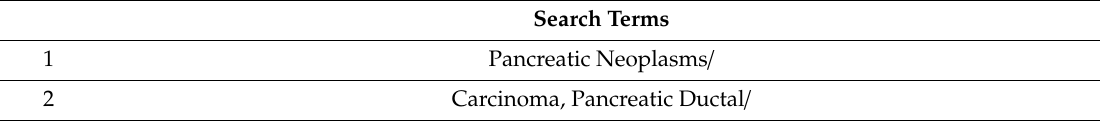
Table A1. MEDLINE ® Search Strategy used to retrieve articles included within this